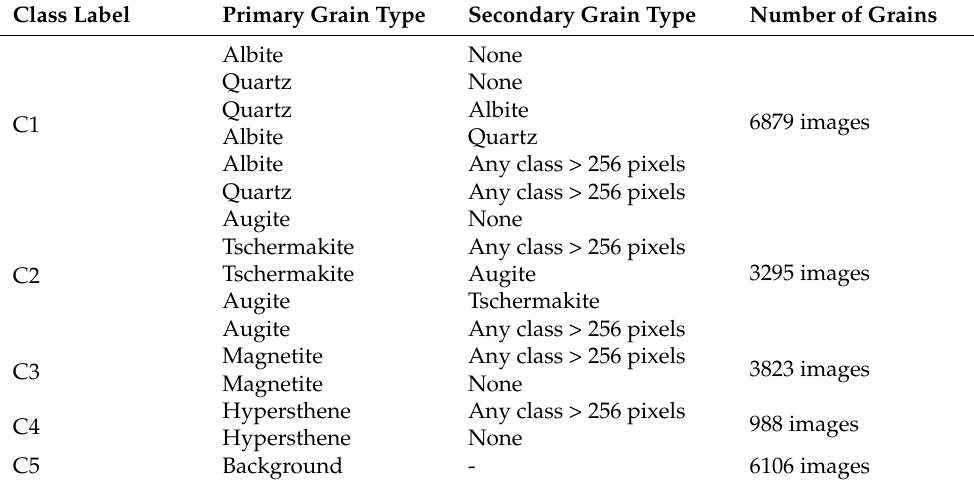
Table 1. Summary of the selected grain